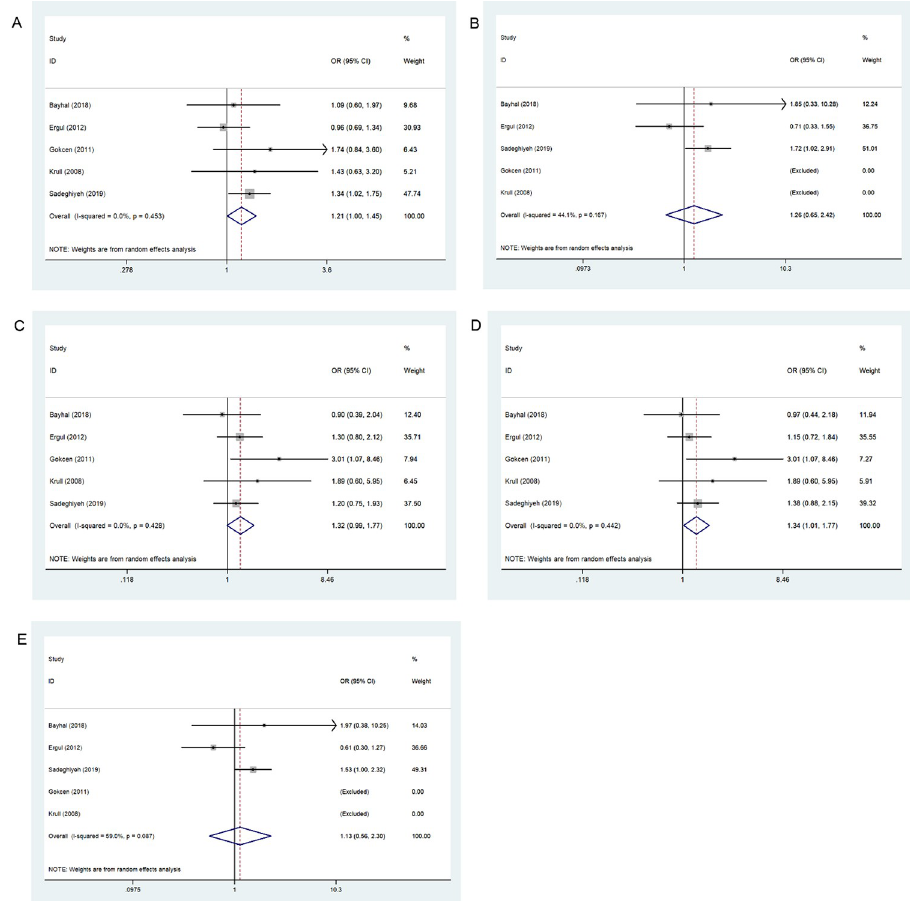
Fig 3. Forest plot of the associations between 1298A > C variation and risk of ADHD in the five genetic models: A, allele contrast; B, homozygous codominant; C, heterozygous codominant; D, dominant; and E, recessive. https://doi.org/10.1371/journal.pone.0271170.g003 Table 6. Summarized ORs with 95% CIs for the association between MTHFR polymorphisms and bipolar disorder.